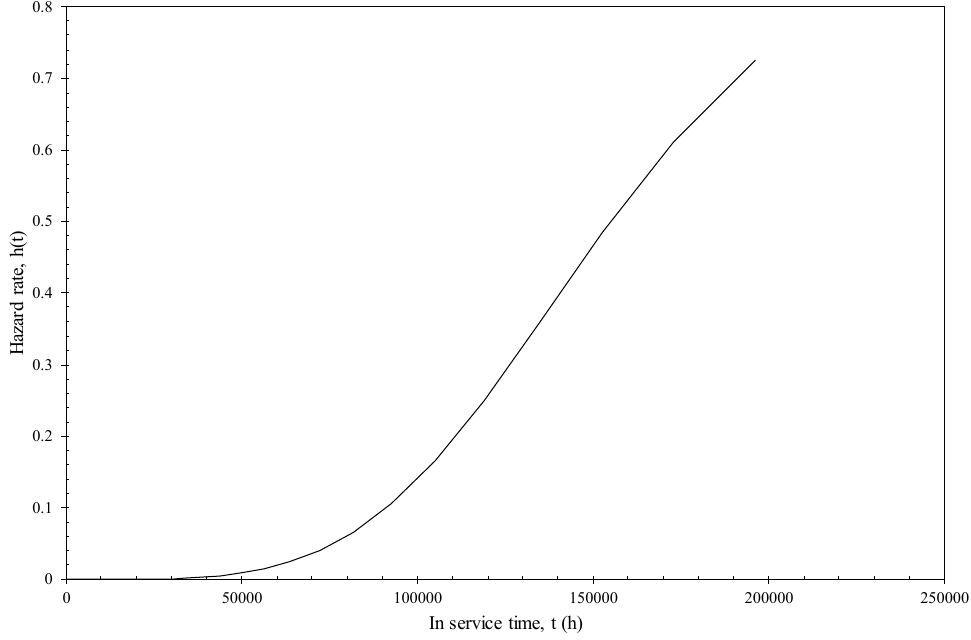
Figure 11. Predicted hazard rates at various times in operation at 823 K and 130 MPa from the model given by Equation (19f).